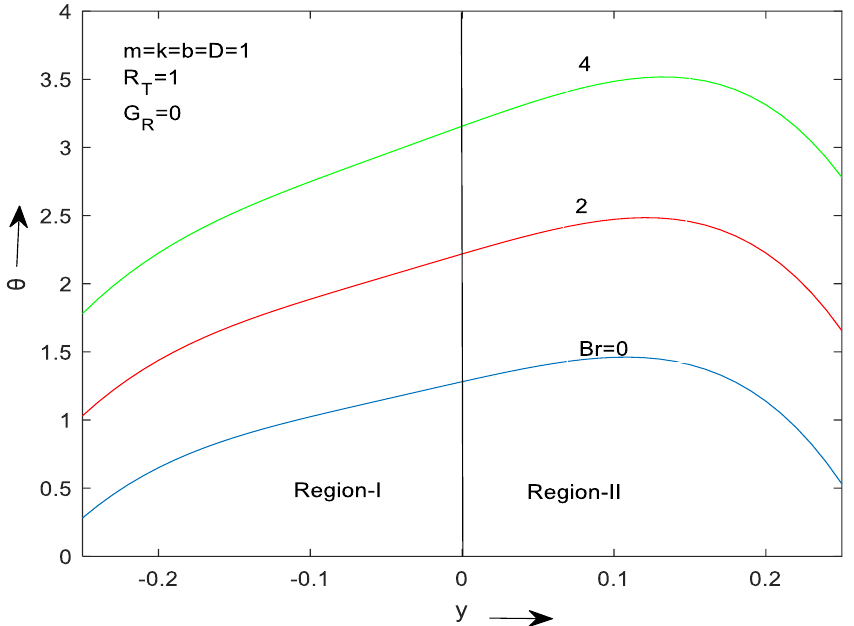
Fig. 3. Temperature profile for different values of B